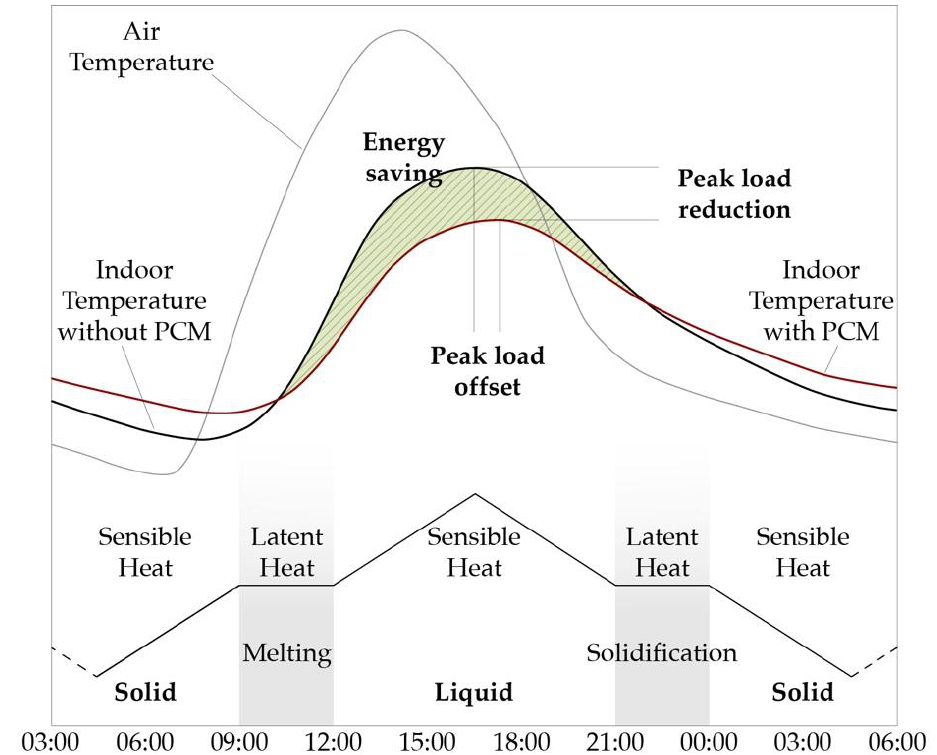
Figure 1. Illustration of potential effect of PCM applied to plaster.